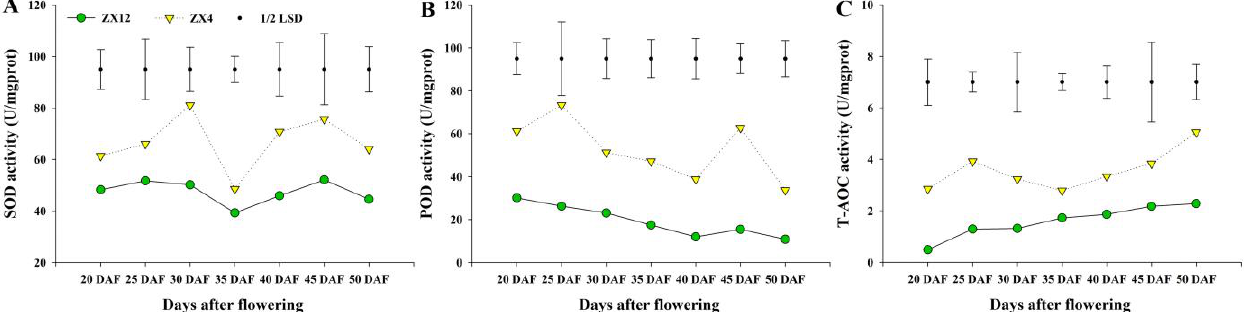
Figure 2. SOD, POD, and T-AOC activities of ZX4 and ZX12 seeds at different maturity stages. ( A ) SOD activities of ZX4 and ZX12 seeds at different maturity stages. ( B ) POD activities of ZX4 and ZX12 seeds at different maturity stages. ( C ) T-AOC activities of ZX4 and ZX12 seeds at different maturity stages.